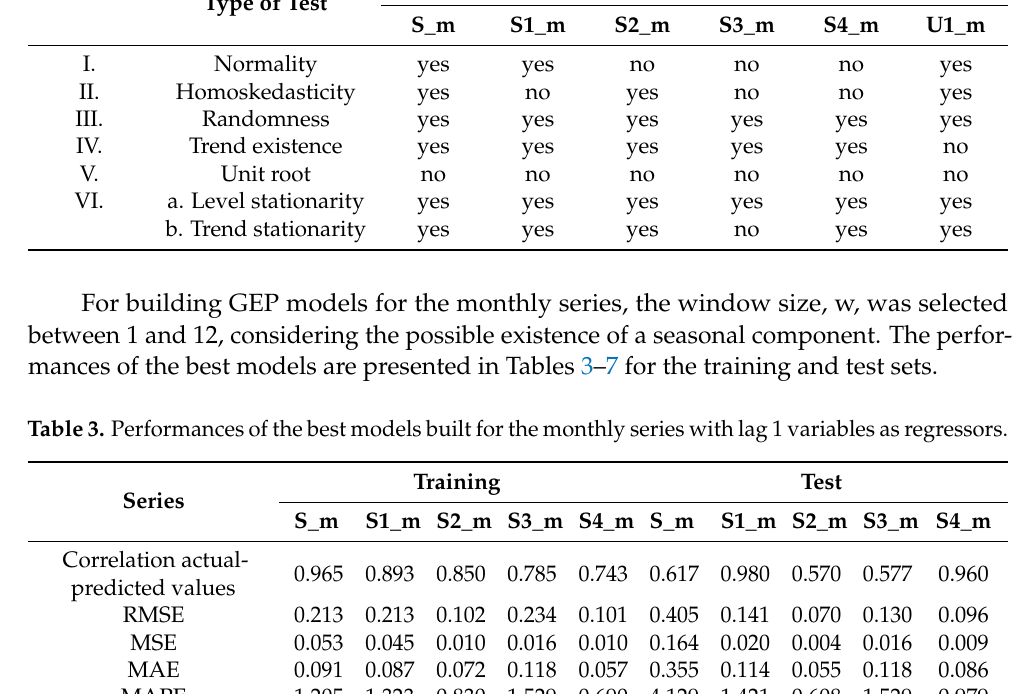
Table 2. Results of statistical tests on the monthly series. Type of Test